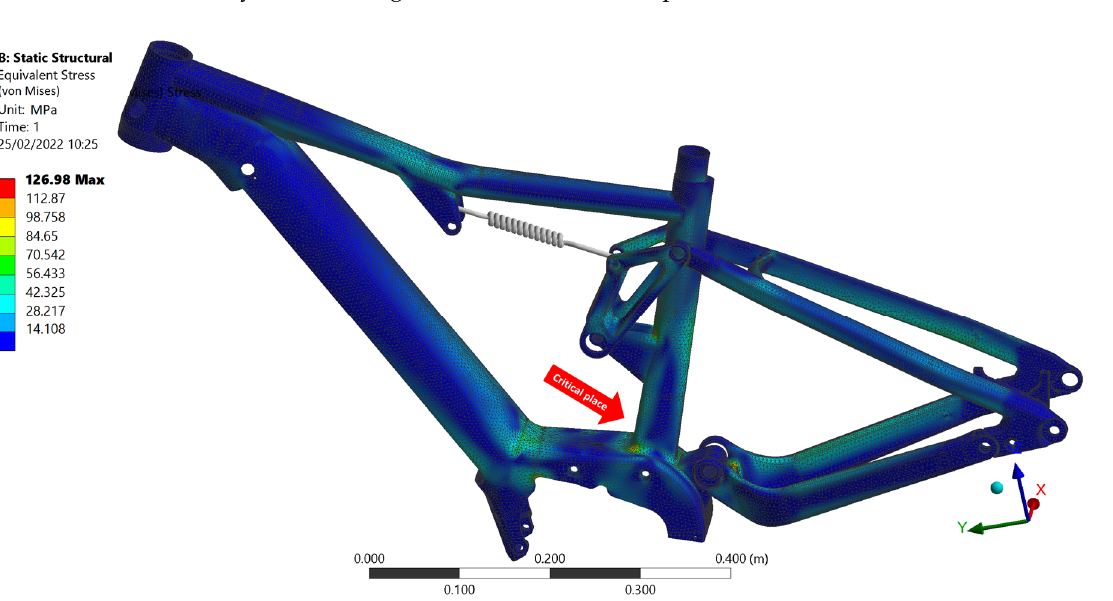
Figure 5. FEM model with the critical place of the structure.